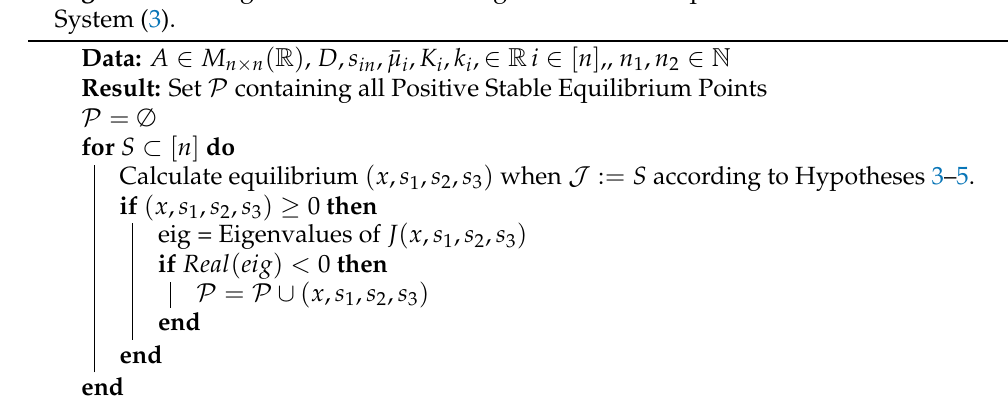
Algorithm 1: Algorithm for Evaluating the Possible Equilibrium Points of System